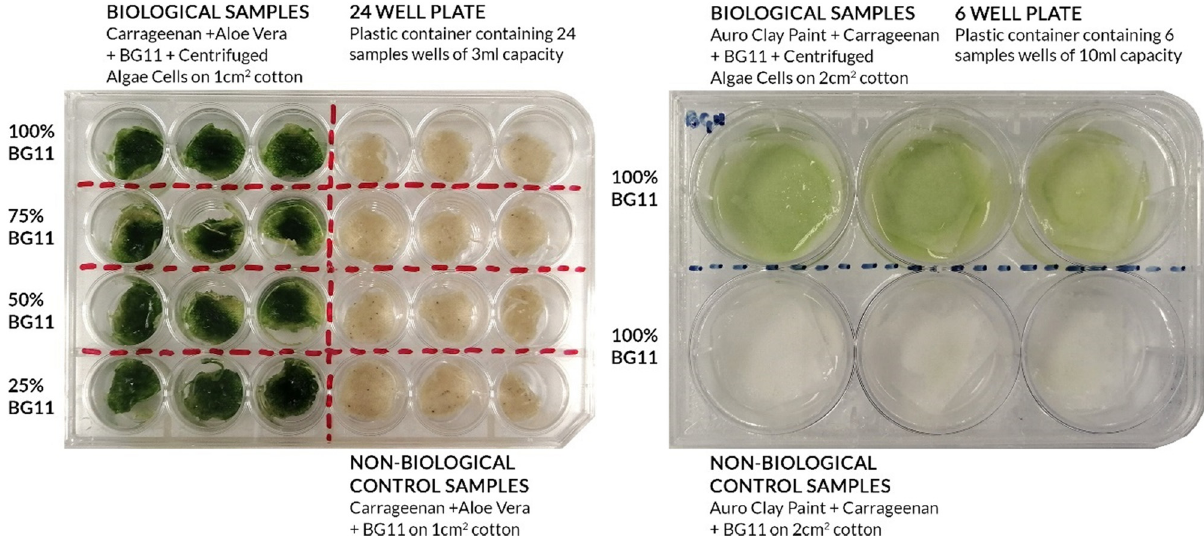
Figure 1: ( Left ) Closed lid incubations in 24 - well plates with four BG11 nutrient dilutions, ( right ) open lid incubations in 6 - well plates with full strength BG11.